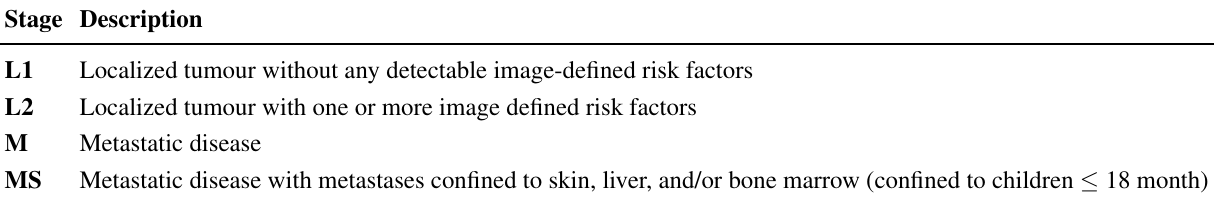
Table 1. Four major stages in “the international neuroblastoma risk group staging